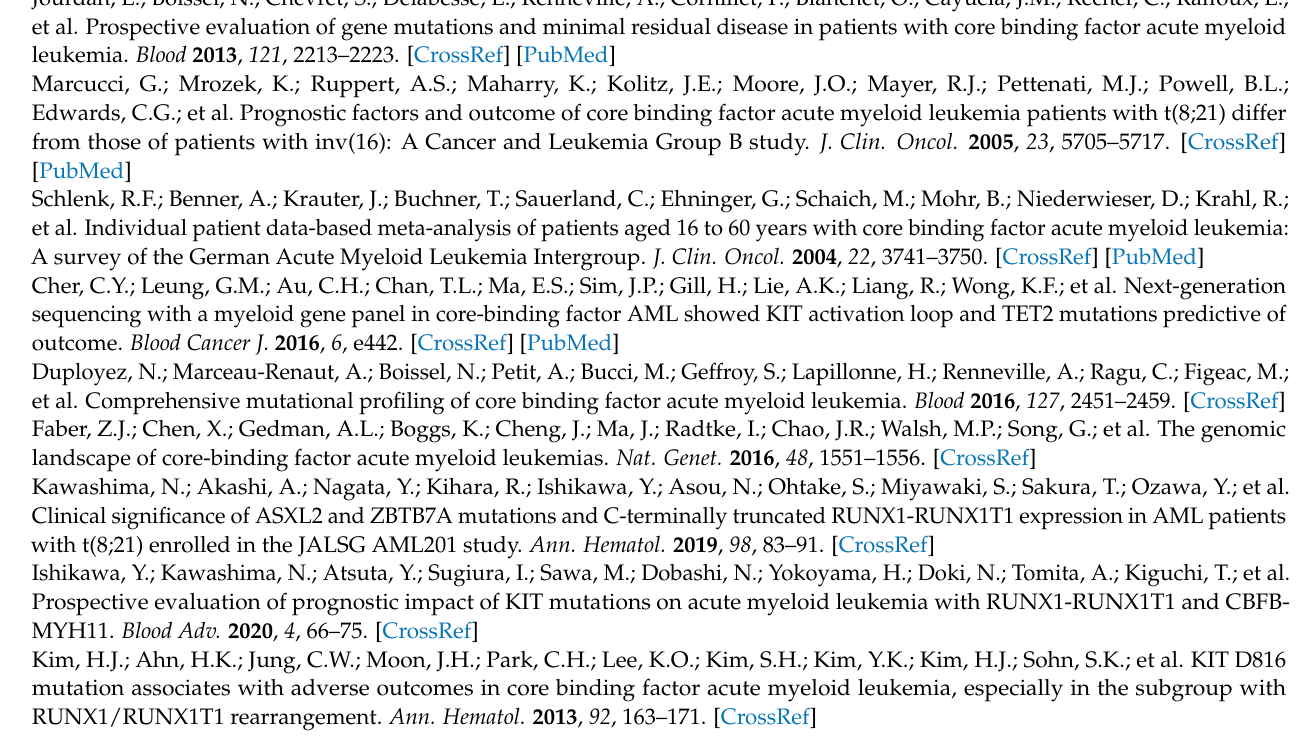
Table S3: Multivariate analysis to reveal an impact of KIT or D816 KIT mutations on survival outcomes; Table S4: Impact of transplant type on kinetics of RUNX1–RUNX1T1 transcript levels; Table S5: Sensitivity and specificity of RUNX1–RUNX1T1 MRD-positive patients defined by various cutoffs at each time point; Table S6: Multivariate analysis to reveal an impact of RUNX1–RUNX1T1 quantification at each time point on survival outcomes; Supplementary